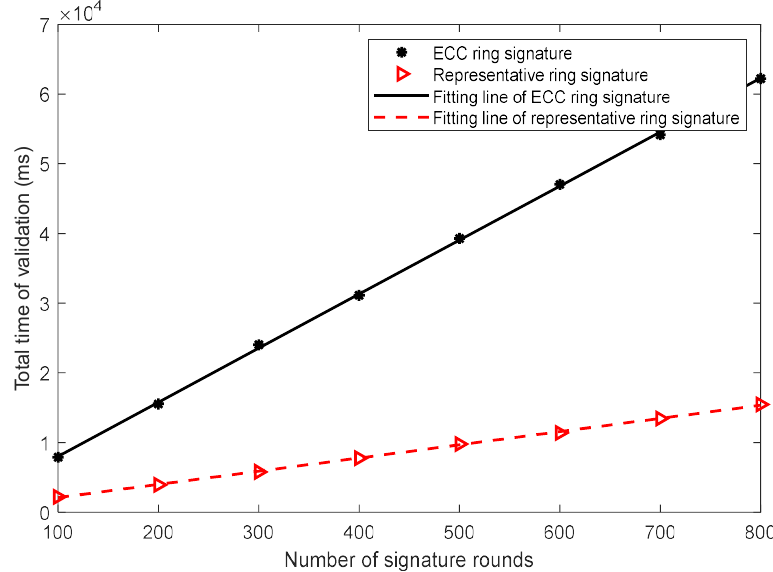
Figure 10. The total time comparison consumed for signature